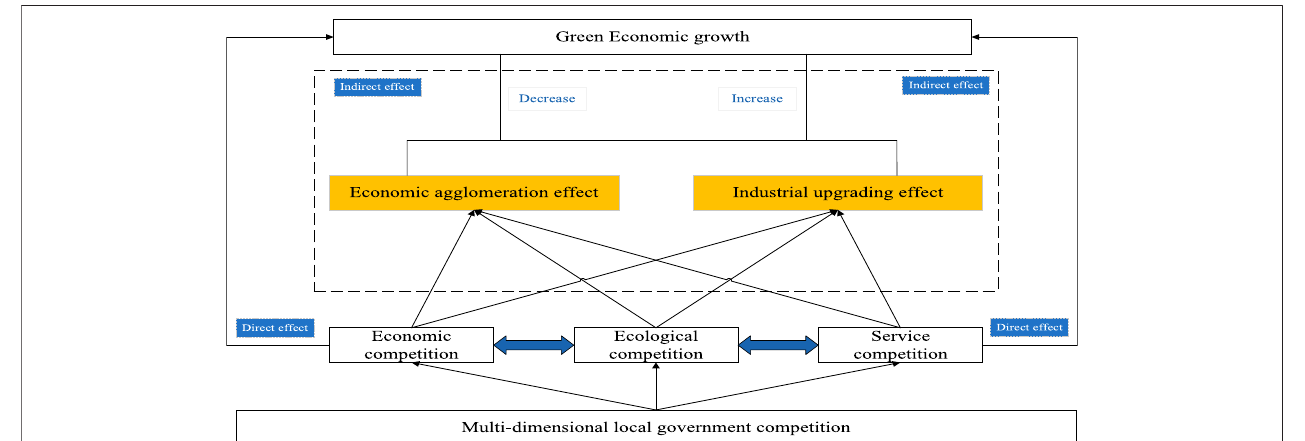
FIGURE 1 | In fl uences